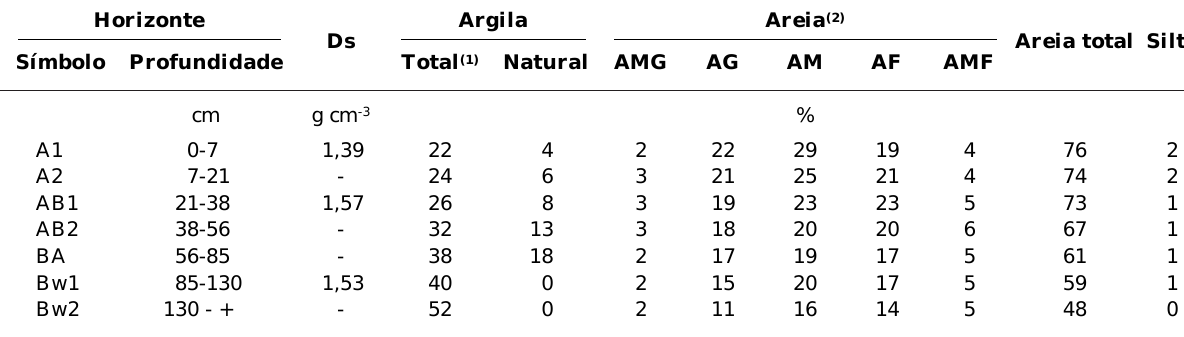
(1) RT (Relação Textural) = 1,6. (2) AMG = areia muito grossa; AG = areia grossa; AM = areia média; AF = areia fina; AMF = areia muito fina.